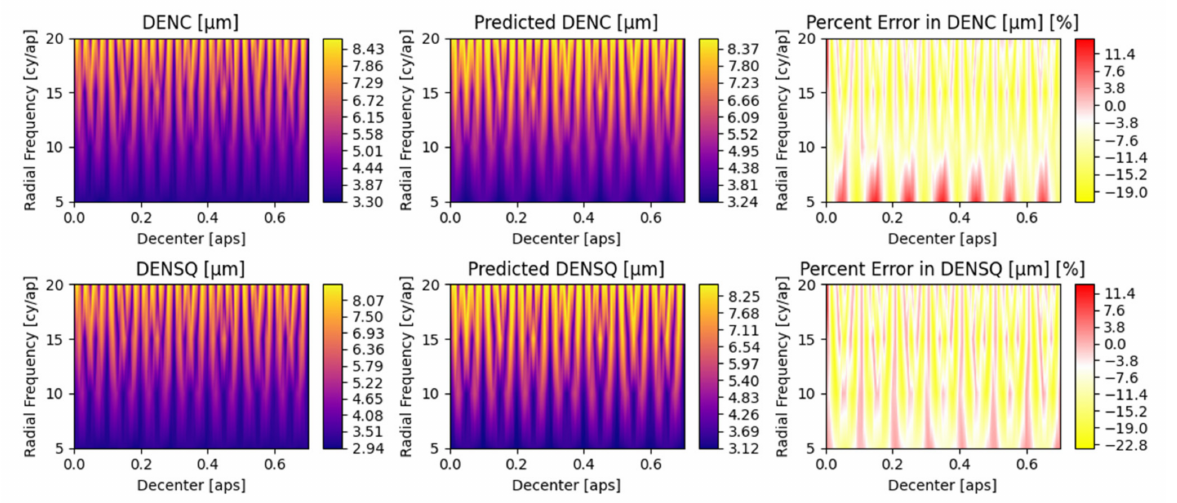
Figure A4. Decenter versus radial frequency. ( κ = ω = η = ζ = 0, σ = 0.05, θ = 45 ◦